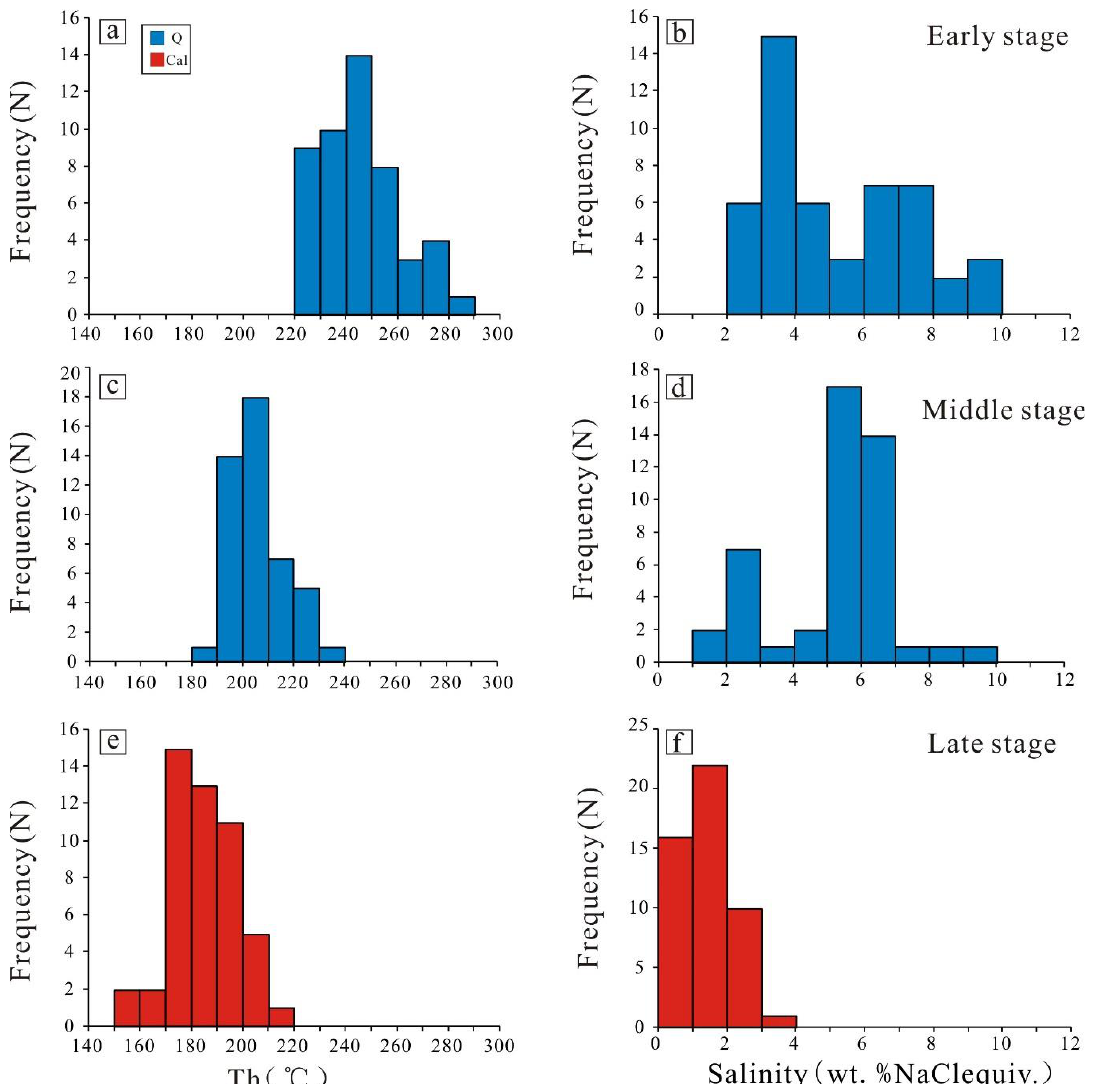
Figure 8. Frequency histograms of the total homogenization temperatures (Th) and salinities of the fluid inclusions from different stages of the Changkeng–Fuwan Au deposit. Early stage ( a , b ); middle stage ( c , d ) and late stage ( e , f ). Qtz, quartz; Cal, calcite.